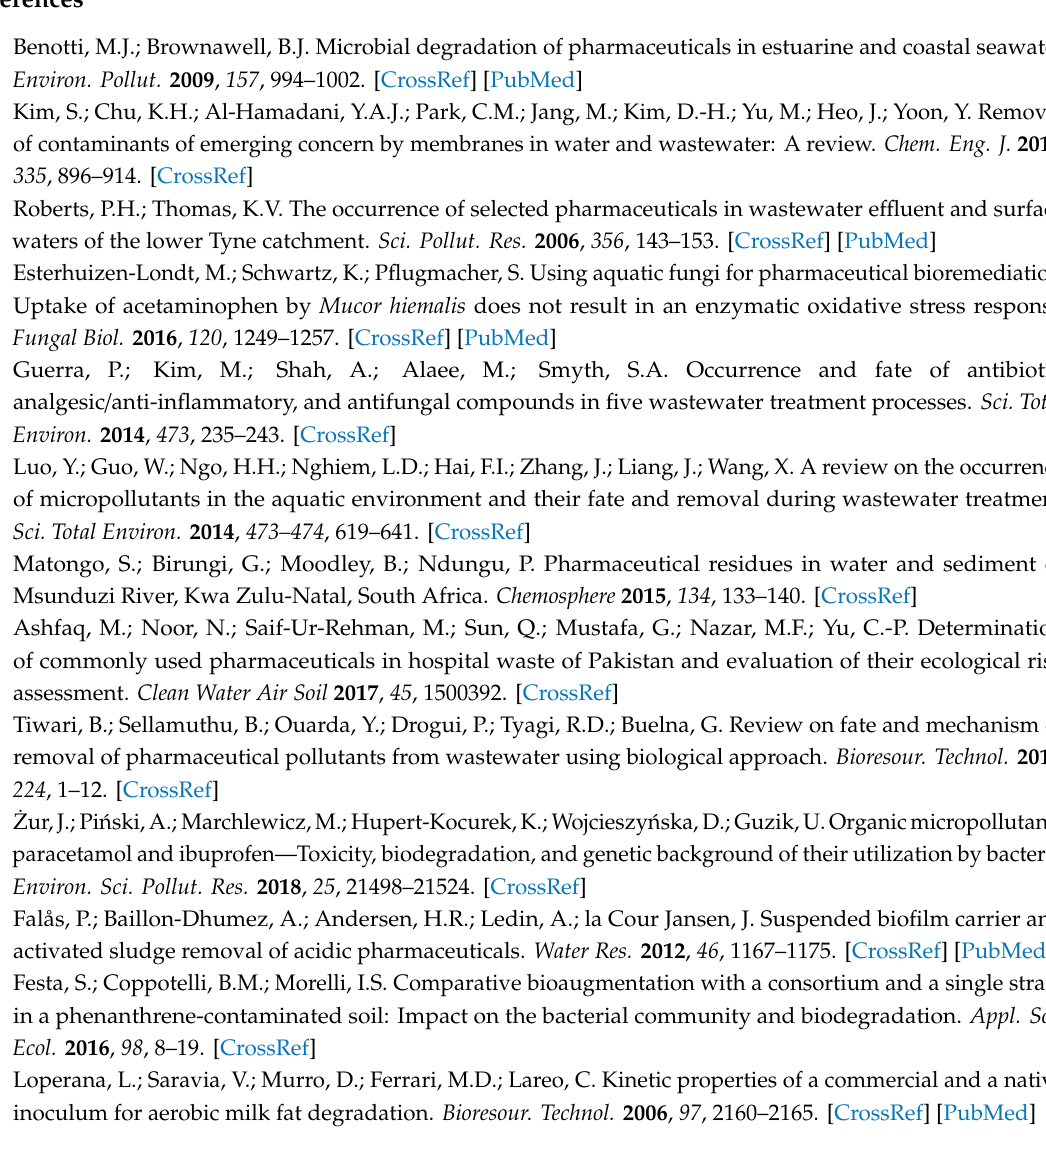
Table S1: The electrospray mode of the analyzed compounds and transition of m / z of precursors to m / z of